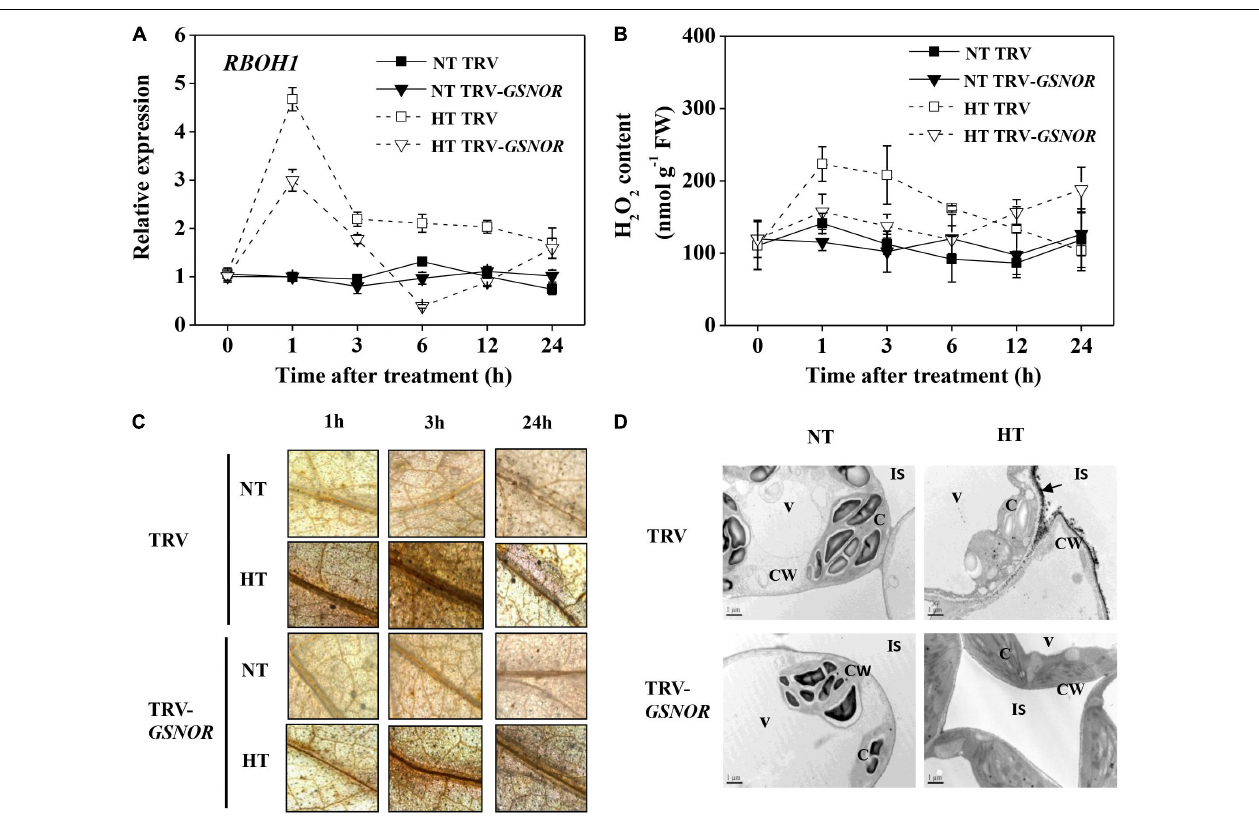
FIGURE 4 | Silencing of SlGSNOR1 impaired apoplastic H 2 O 2 accumulation in response to high temperature. (A) Relative transcript level of SlRBOH1 , encoding NADPH oxidase. (B) Chemical quantification of H 2 O 2 in leaves. (C) Histochemical detection of H 2 O 2 in leaves using 3, 3’-diaminobenzidine (DAB). (D) Subcellular localization of H 2 O 2 leaf cells using CeCl 3 . Black arrows indicate apoplastic H 2 O 2 accumulation. Samples were taken at 3 h after heat stress. C, chloroplast; CW, cell wall; IS, intercellular space; V, vacuole. Data are means of five replicates ( ± SD). NT, normal temperature; HT, high